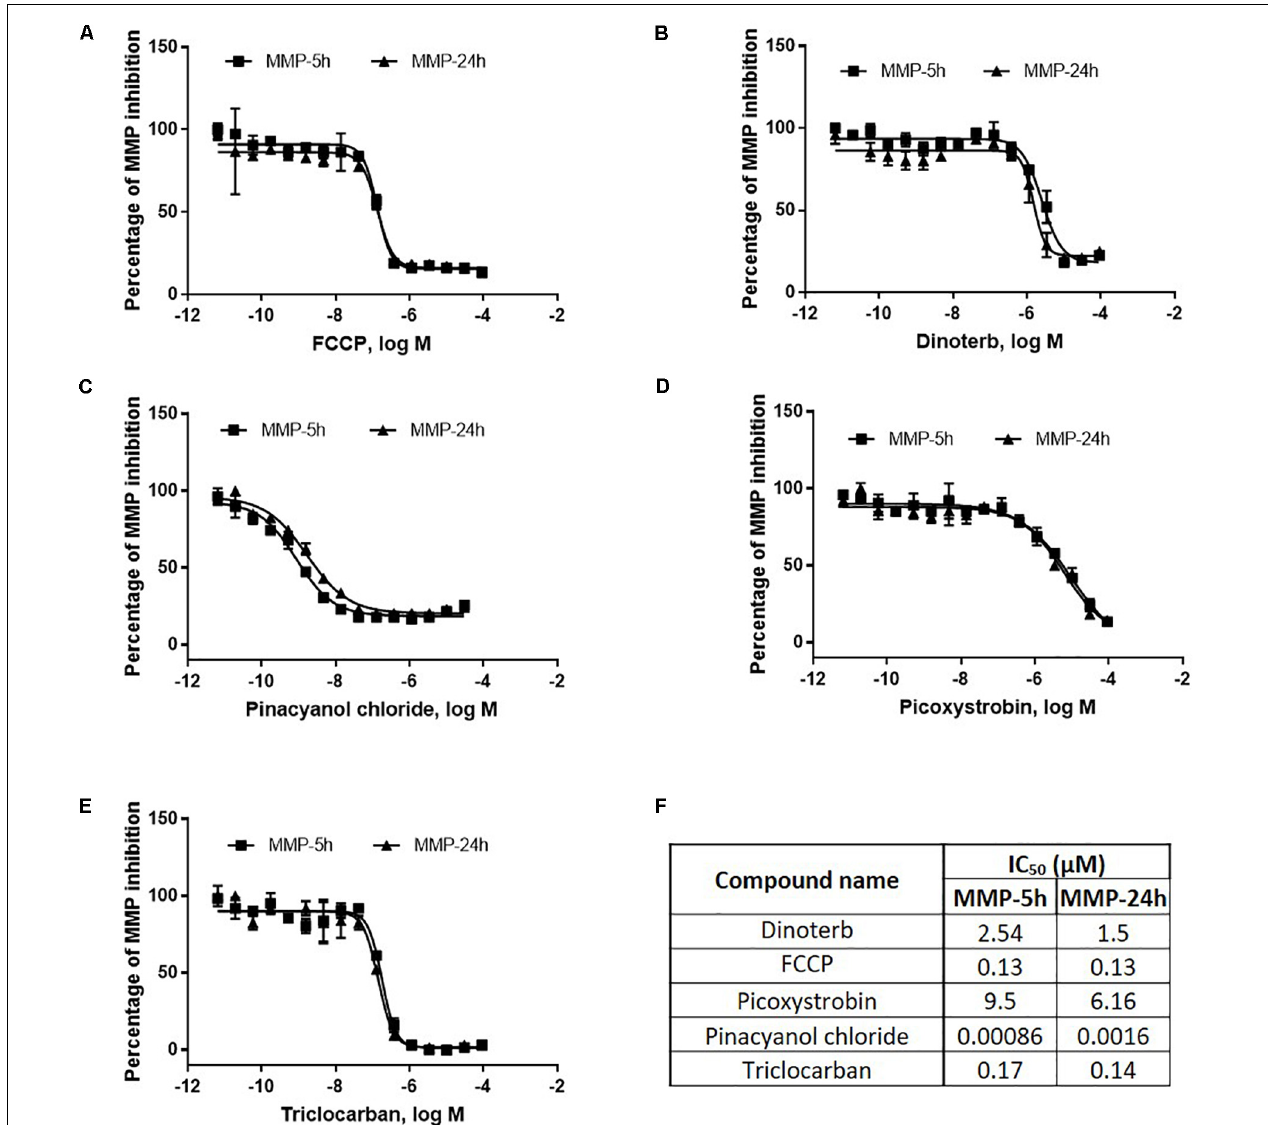
FIGURE 1 | Concentration-response of mitochondria toxicants, FCCP (A) , dinoterb (B) , pinacyanol chloride (C) , picoxystrobin (D) , and triclocarban (E) in MMP assay. IC 50 values (F) of MMP and cytotoxicity assays were listed for these five compounds. Inactive compound was defined by its efficacy of less than 20% compared to DMSO control. AC16 cells were treated by each compound in multiple concentrations ranging from 6.4 pM to 92 µ M for 5 h, or 24 h. IC 50 – IC 70 values of compounds that decreased MMP at 5 h were used as treatment condition in proteomics